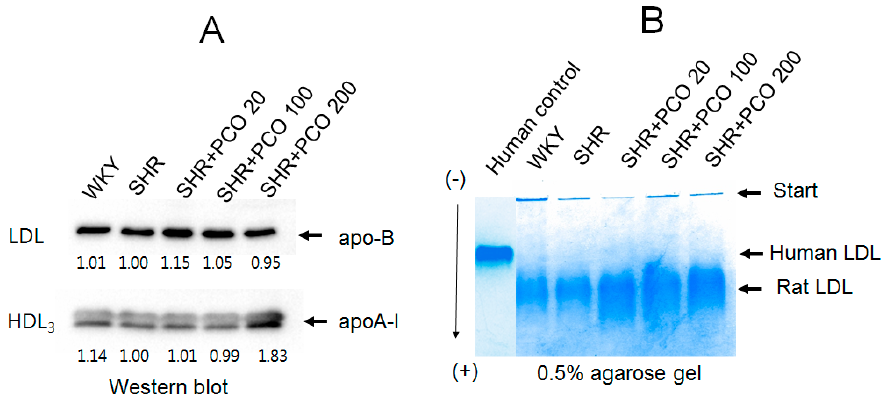
Figure 6. Electrophoretic profiles of LDL and HDL. ( A ) Immunodetection of LDL and HDL 3 using anti-apoA-I and anti-apo-B antibodies. ( B ) Electromobility of LDL in agarose gel electrophoresis.